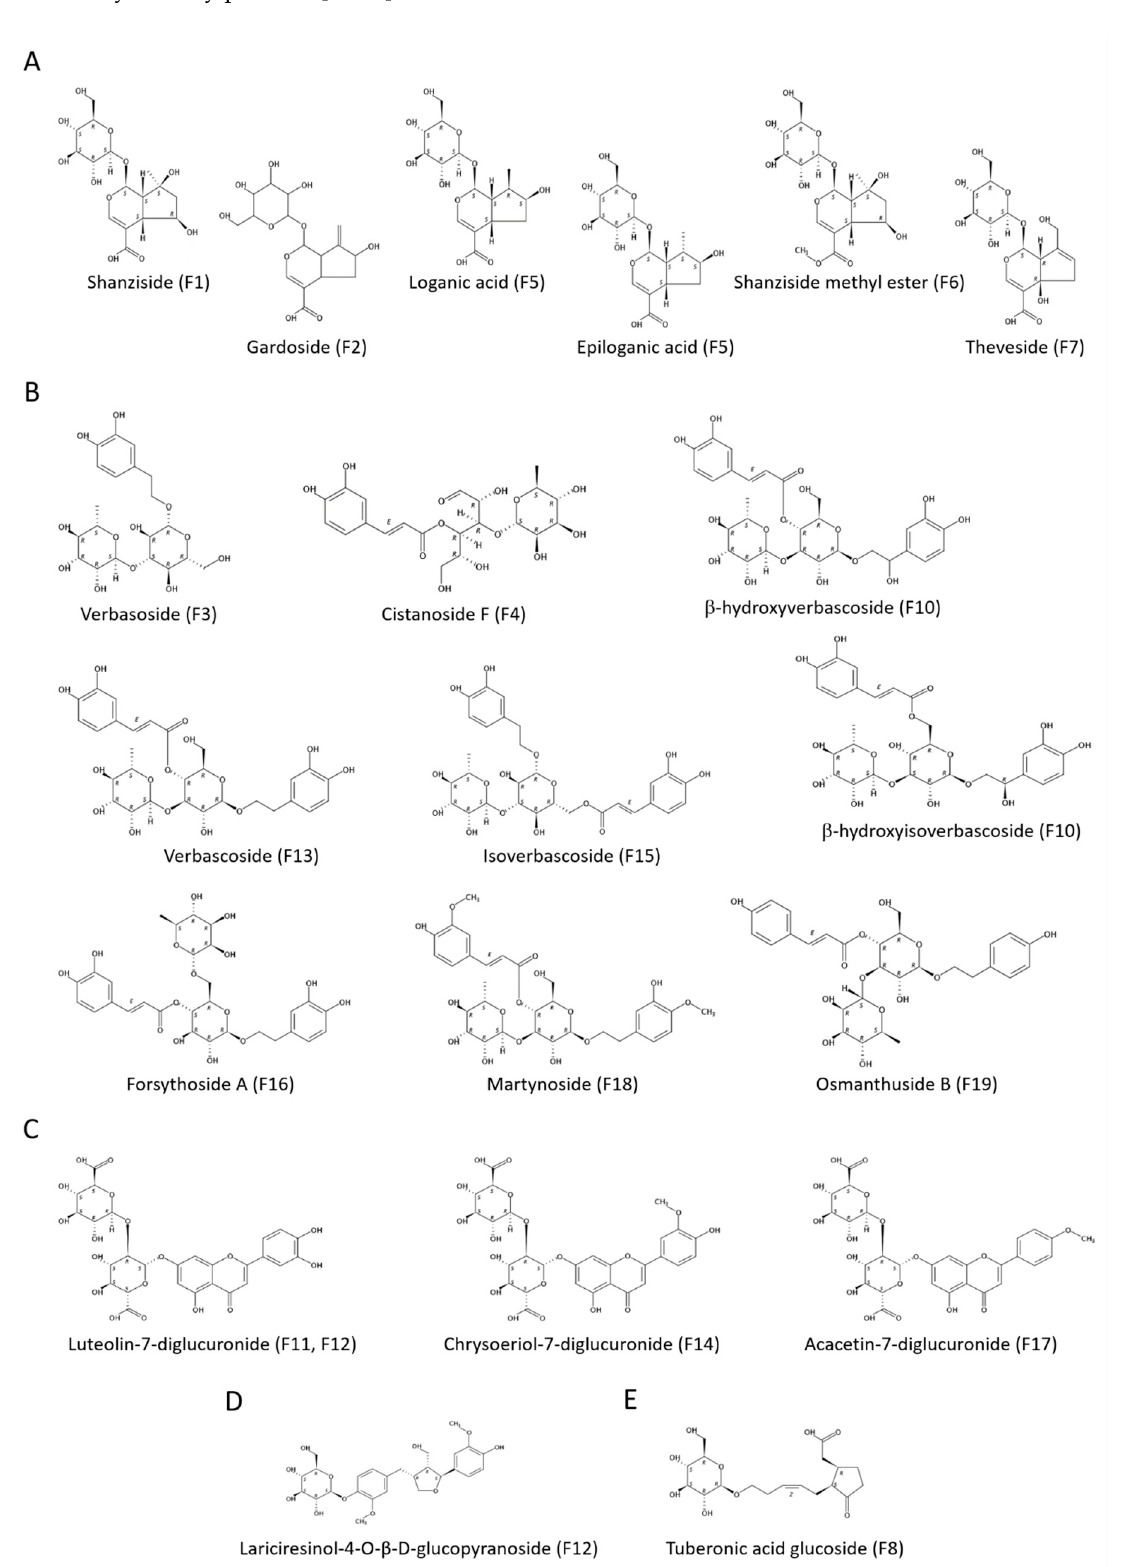
Figure 5. Chemical structures of the major compounds from the fractions classified in ( A ) iridoids, ( B ) glycosylated phenylpropanoids, ( C ) flavonoids, ( D ) lignan, and ( E ) monoterpenoid.